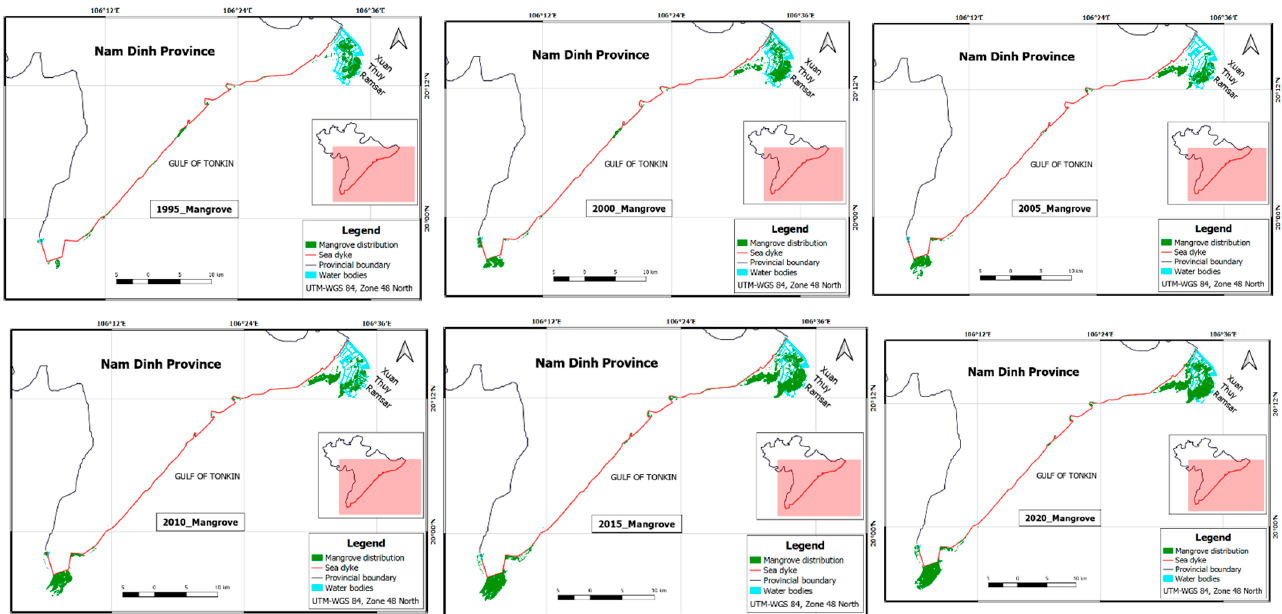
Figure A2. Mangrove distribution maps in Thai Binh between 1995 and 2020.